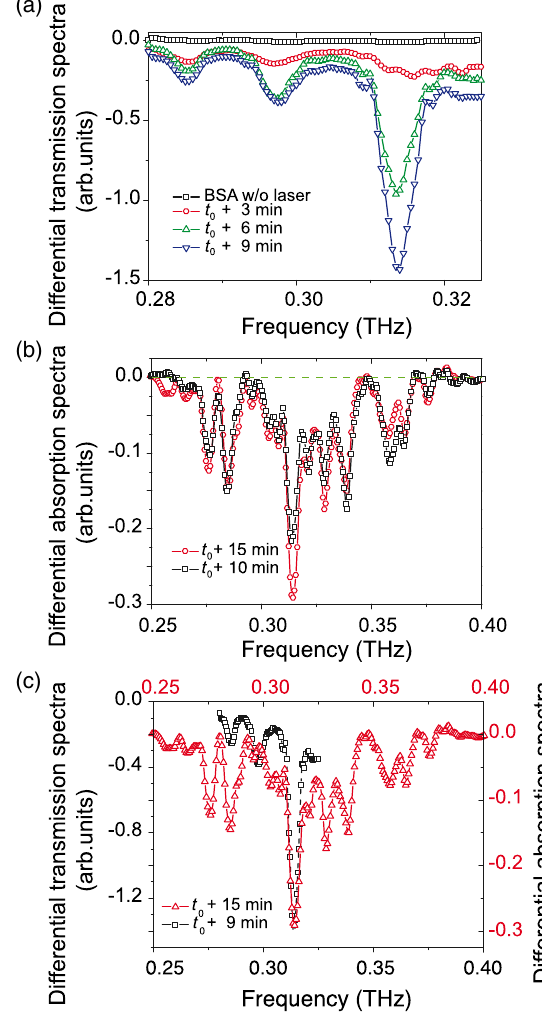
FIG. 4. Differential transmission and absorption spectra as functions of the frequency. (a) Spectra obtained using the microwire probe after subtraction of the water spectrum in the absence of illumination and in the presence of illumination for the reported durations. (b) Spectra obtained using the rectenna, after subtraction of the protein solution without illumi- nation, for the reported durations. (c) Comparison of the two normalized spectra for the longest illumination